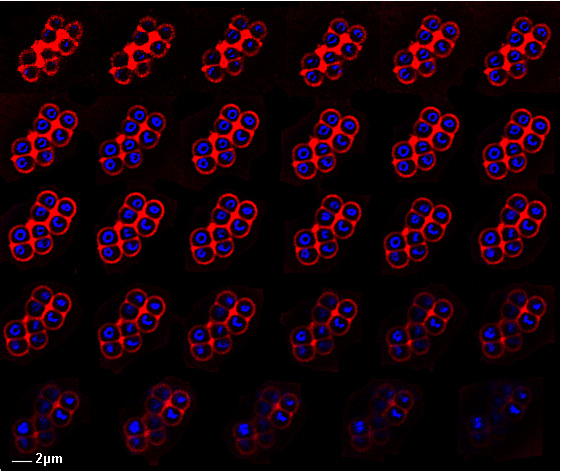
Optical sections of a pair of D. murrayi tetrads. The series is in order from left to right of the images within a row and from top to bottom of the rows within the figure. Images are taken at 100 nm intervals.